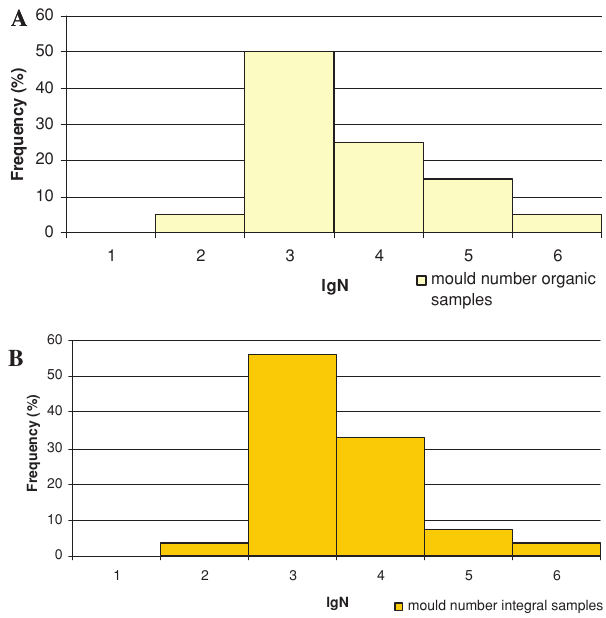
Figure 2. Frequency distribution of the surface mould contamination of apple from organic (A) and integral (B) production